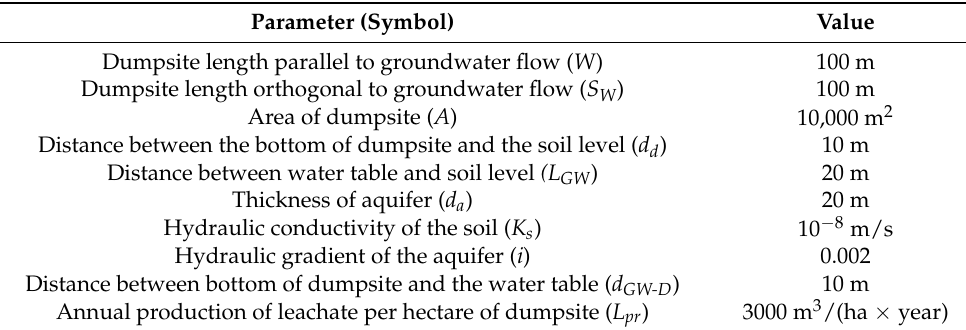
Table 2. Baseline conditions assumed for the study.